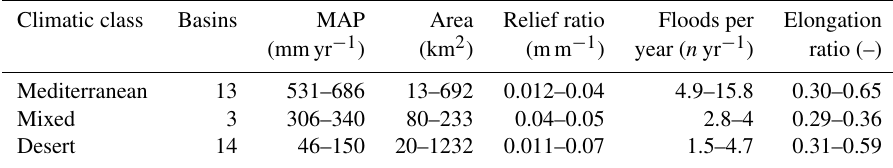
Table 1. Summary of basin properties (minimum and maximum) in the three regions. Climatic class Basins MAP Area Relief ratio Floods